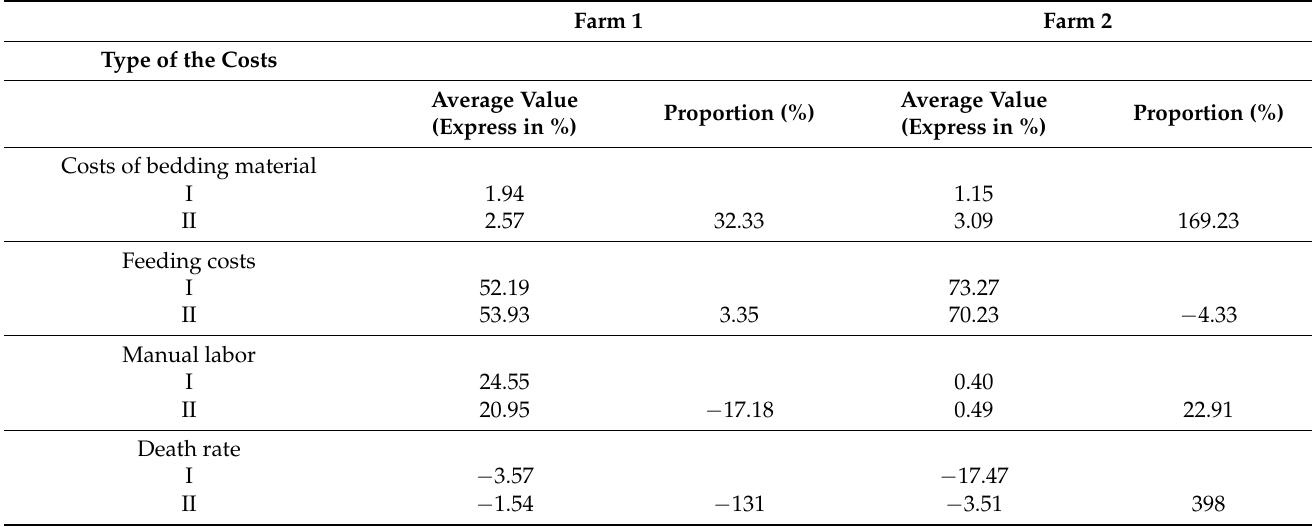
Table 8. Calculated proportions between different types of costs on Farms 1 and 2. Farm 1 Farm